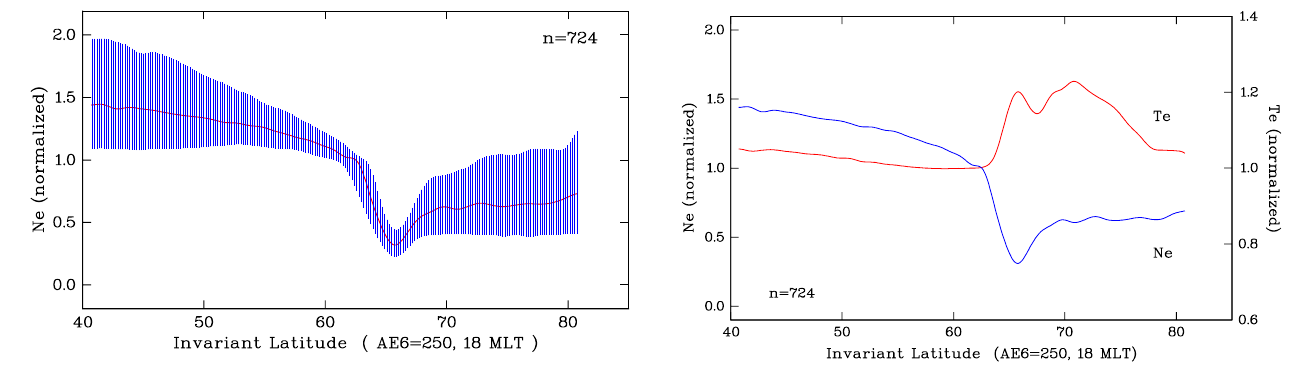
Fig. 11. Mean latitudinal profiles of the electron density (blue curve) and electron temperature (red curve) at the location of the equatorward trough wall. The format of data presentation corre- sponds to that of Fig. 10 except that this time only the median curves are